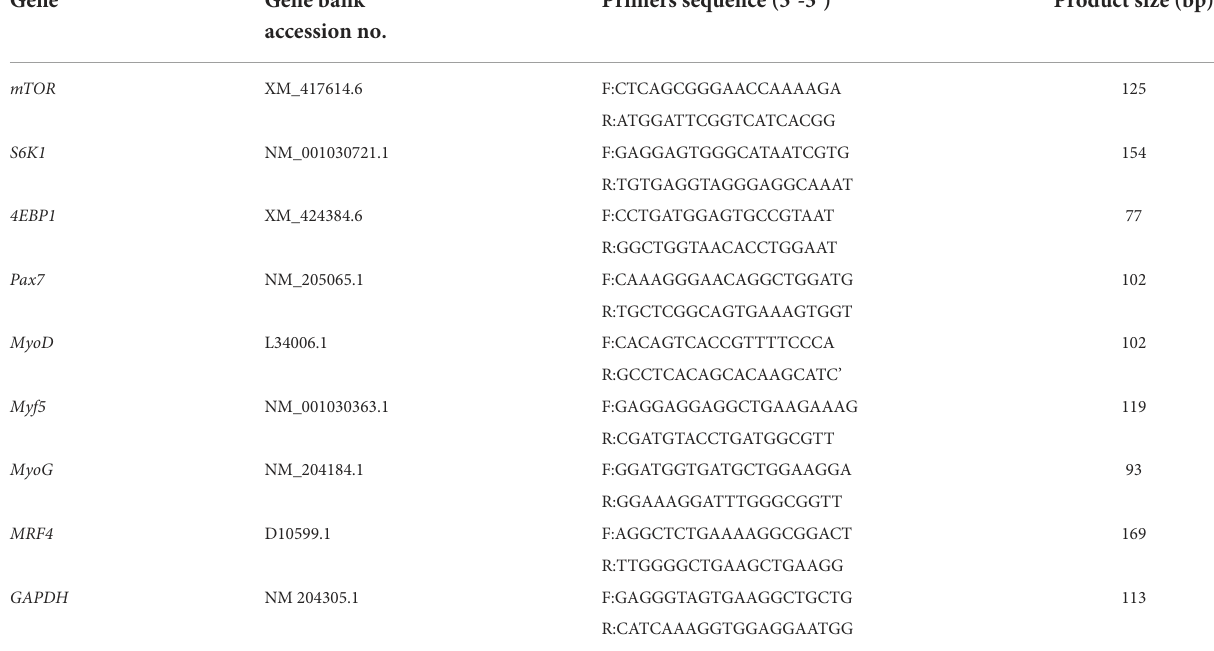
TABLE 2 Primer sequences used for real-time PCR.